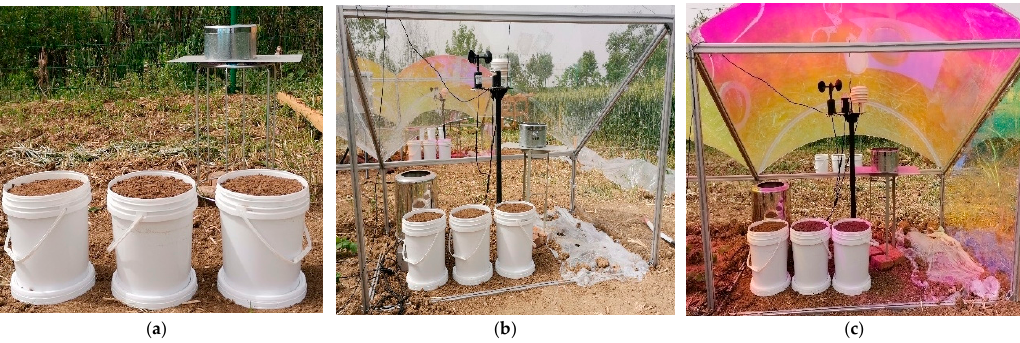
Figure 2. The evaporation containers filled with dried soil are put into a 10 cm water depth tank.